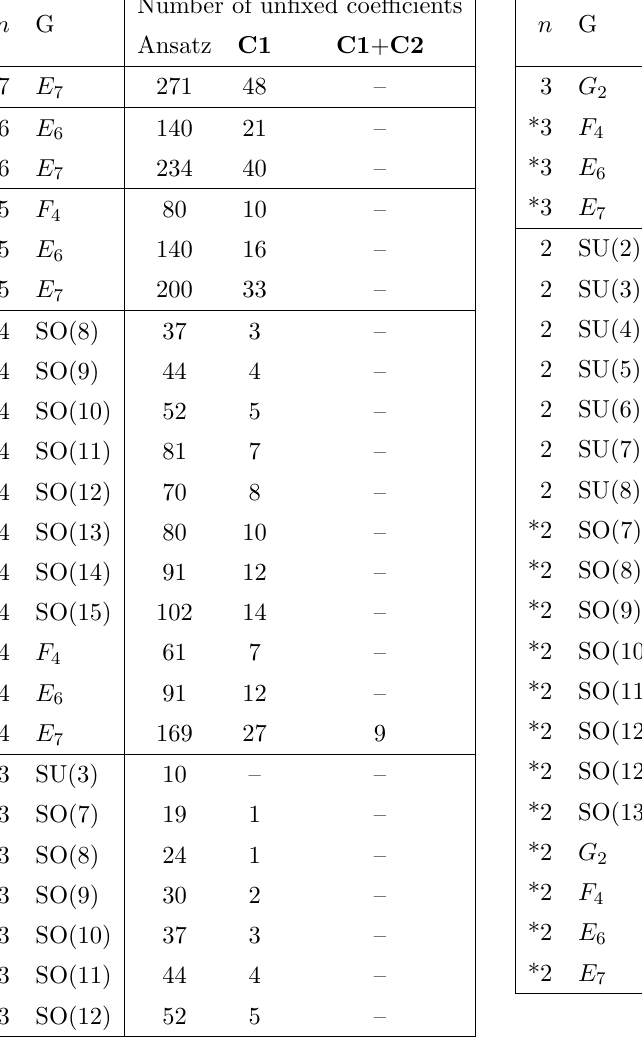
we cannot impose 2